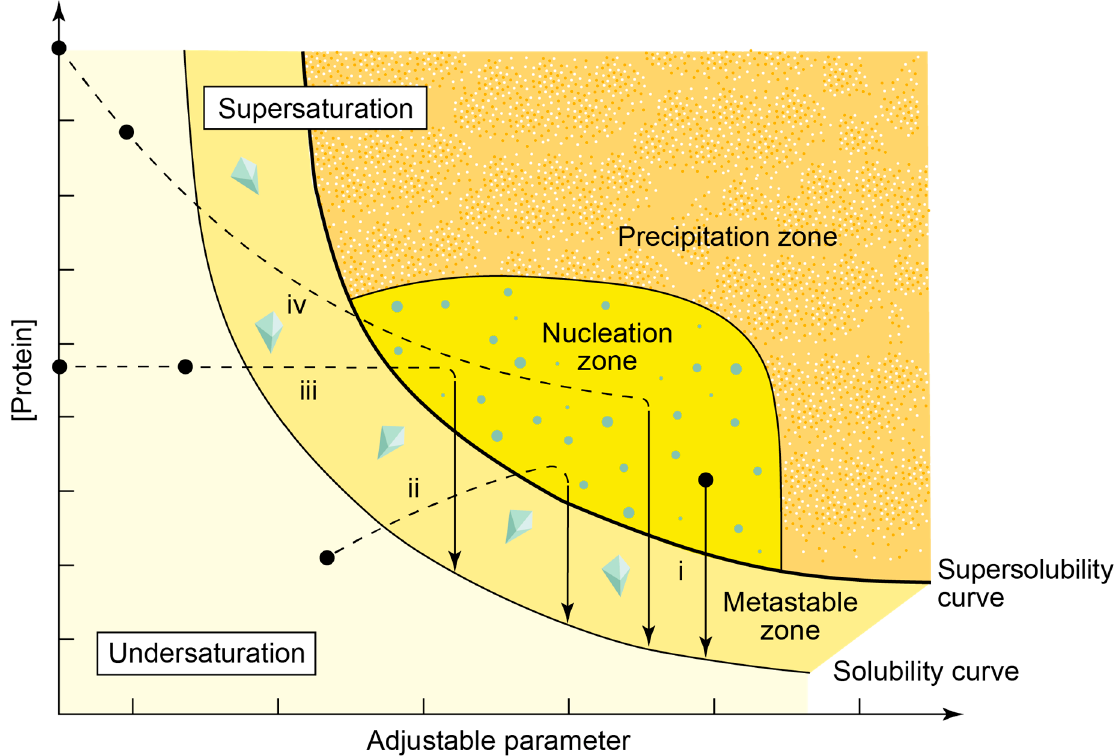
Figure 1. Phase diagram (Protein concentration / precipitation factor diagram). The solubility curve separates the undersaturated with supersaturated, which is also desirable for crystallization. (i) Batch, (ii) Vapor Di ff usion, (iii) Dialysis, (iv) Free-Interface Di ff usion. The superficial area consists of the metastable zone, the nucleation zone or labile zone and the precipitation zone